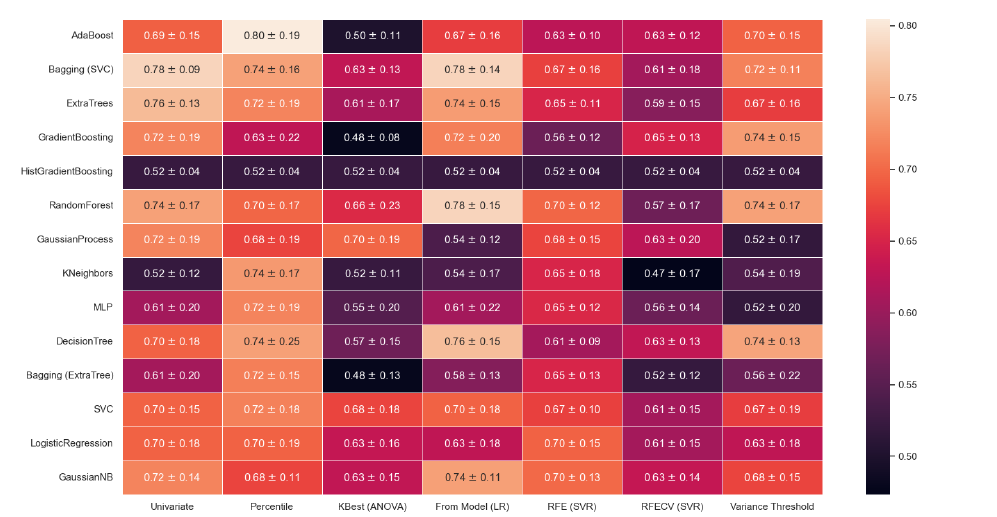
Figure 4. ROC values with a five fold-CV.